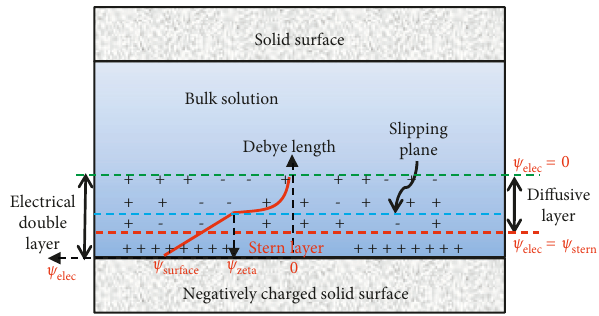
Figure 6: Schematic of a flow in a channel with electrokinetic